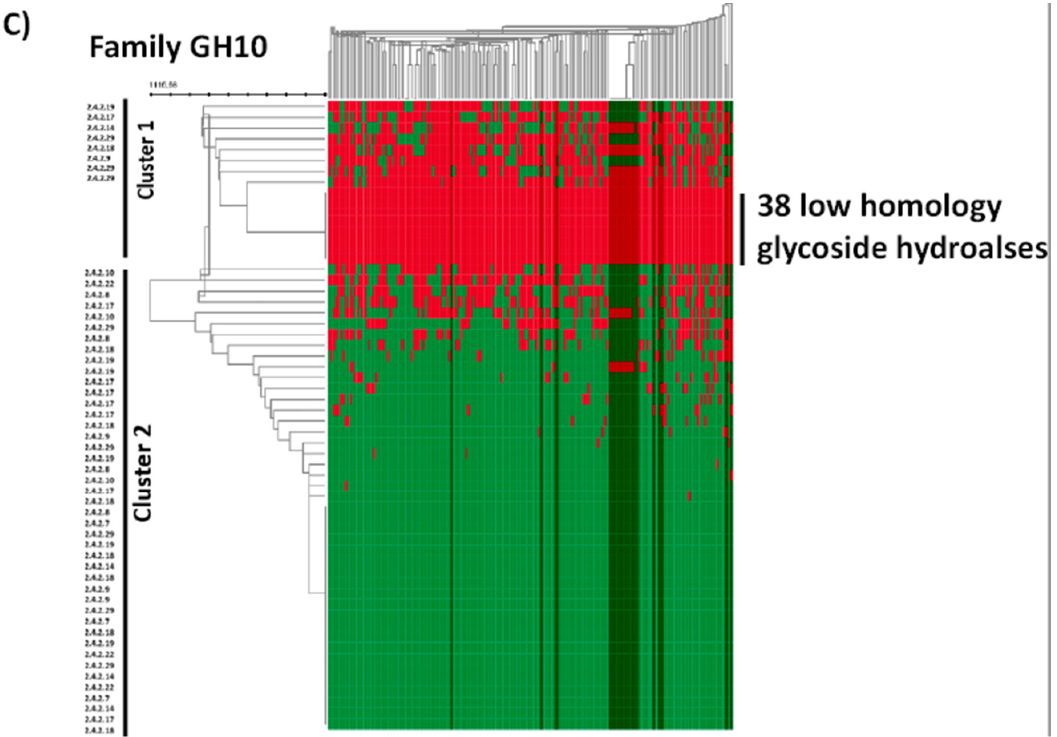
Figure 3. Heatmaps of the GH3 ( A ), GH5 ( B ), and GH10 families ( C ). The X axes represent 171 B. longum strains , and in the Y axes the different GH proteins are included. The red colors indicate homologies (protein level) below 50%, and the green color indicates that the homology is higher than 50%. The B. longum subsp. infantis strains are represented in darker columns.